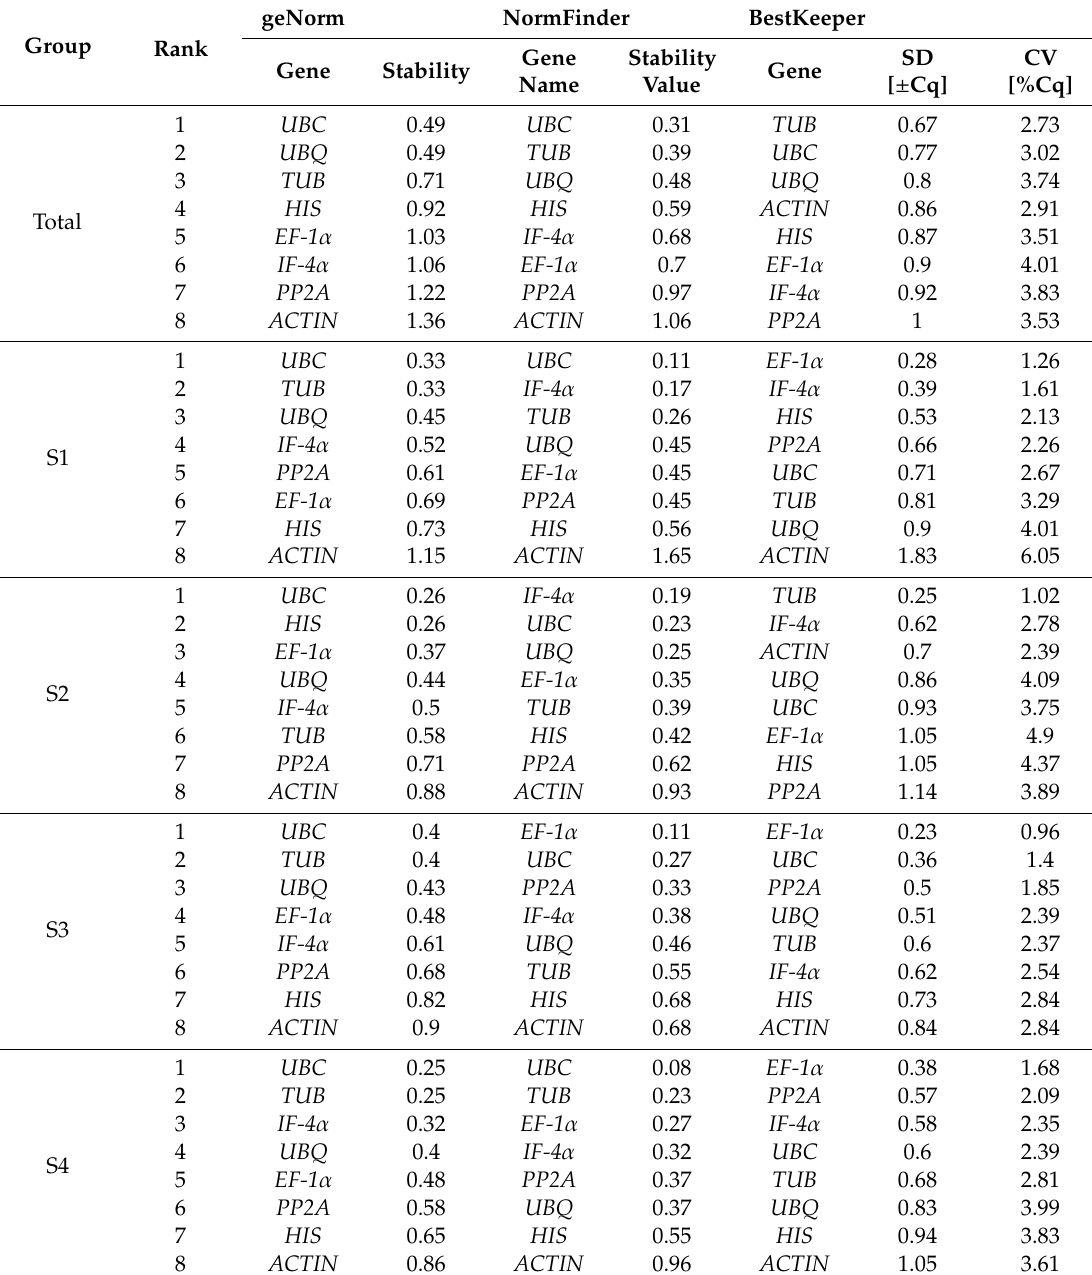
Table 2. Gene expression stability ranking of geNorm, NormFinder and